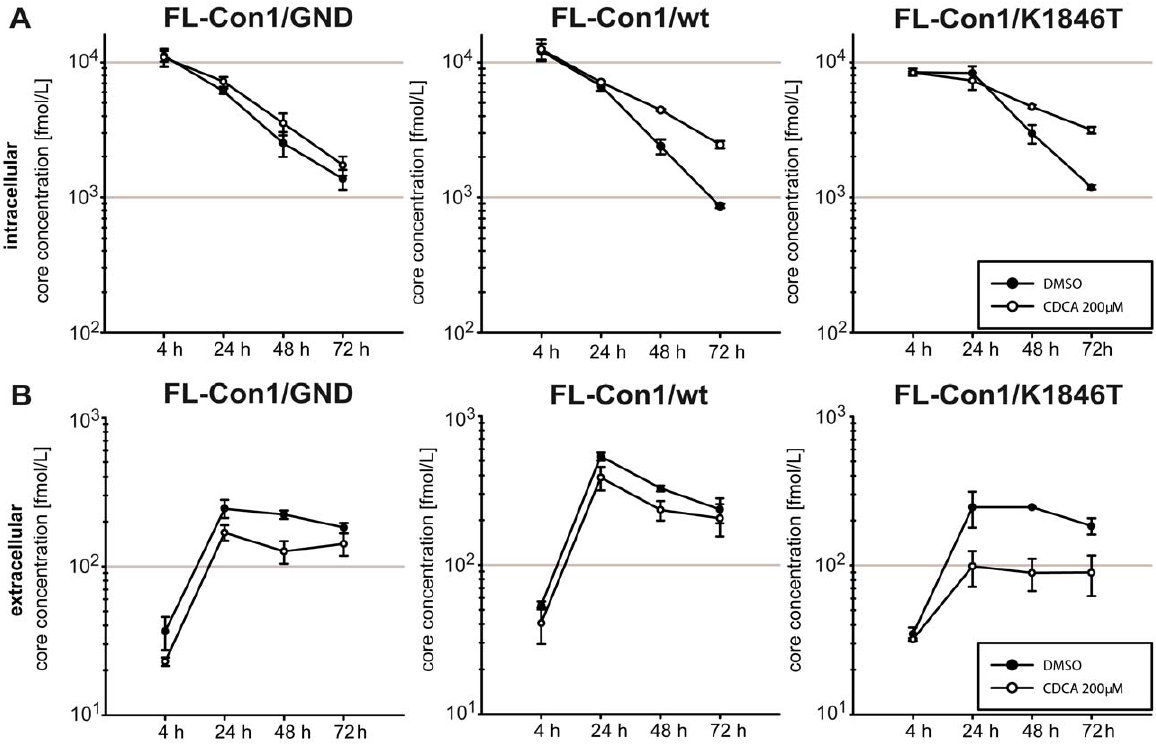
Figure 6. CDCA stimulates replication of full length Con1 genomes with or without adaptive mutations. Given full length Con1 genomes were transfected into Lunet G-Luc cells. At 4 h post transfection cells culture media were replaced with culture fluid with or without 200 m M CDCA. Intracellular (A) and extracellular (B) levels of HCV core protein reflecting viral translation/RNA replication and secretion of virions, respectively, were determined using a commercial ELISA.